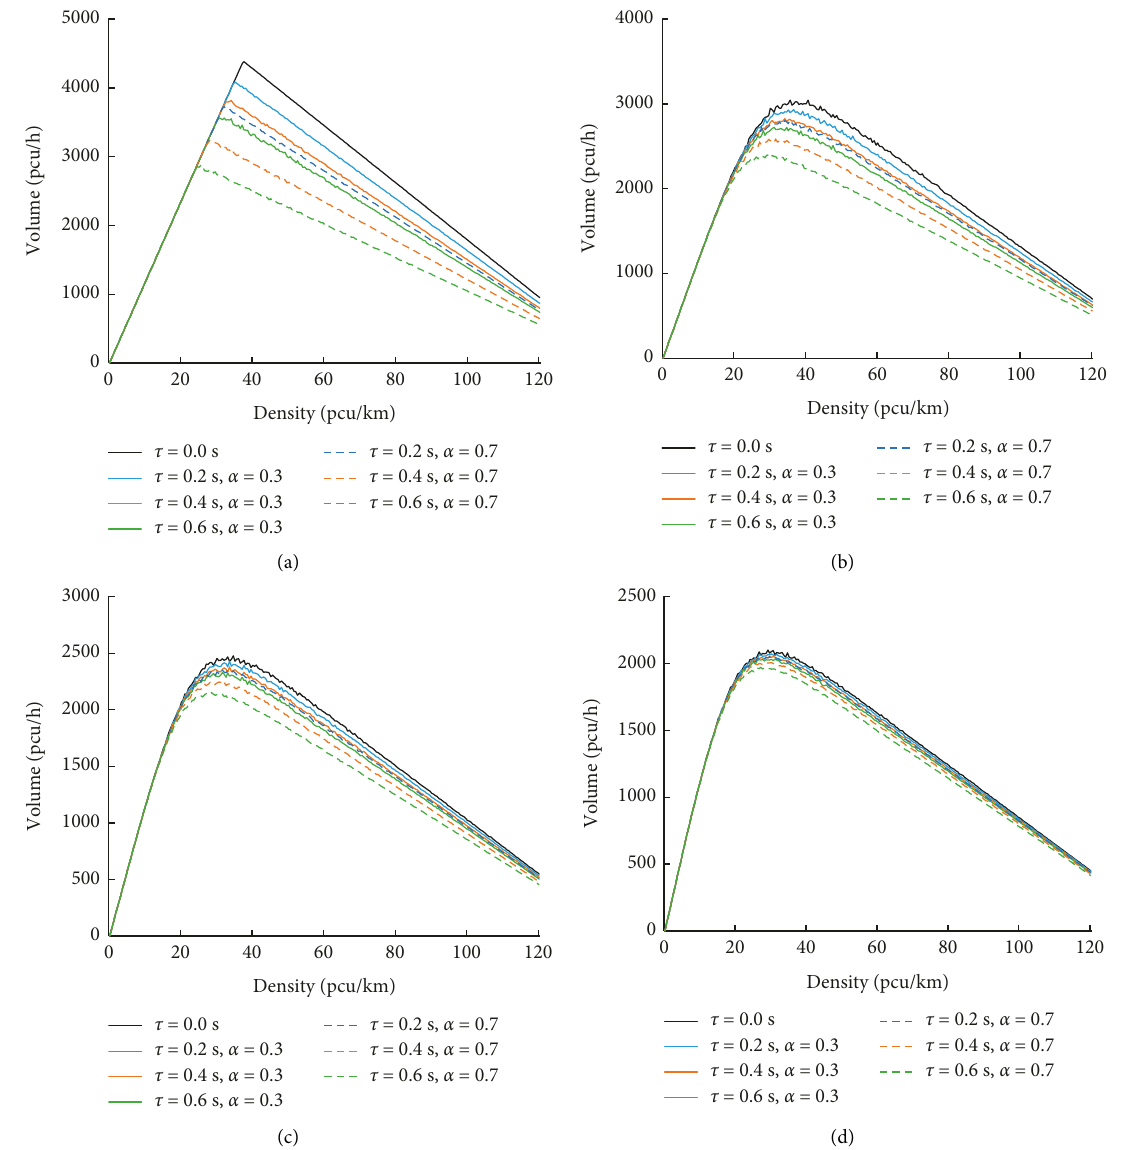
Figure 12: Traffic capacity with multiple transmission delay. (a) No HDVs. (b) 25% HDVs. (c) 50% HDVs. (d) 75%